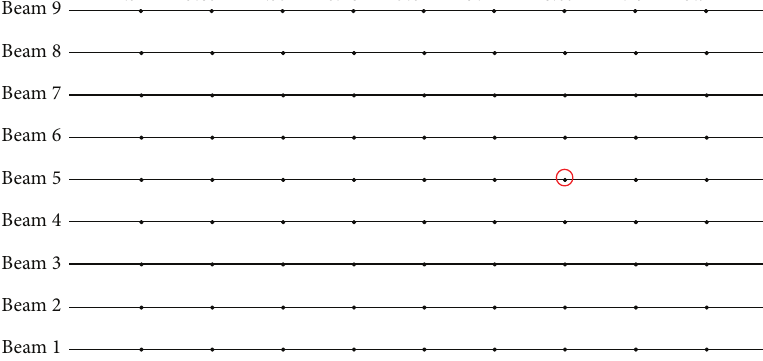
Figure 6: Schematic layout of data extraction locations.